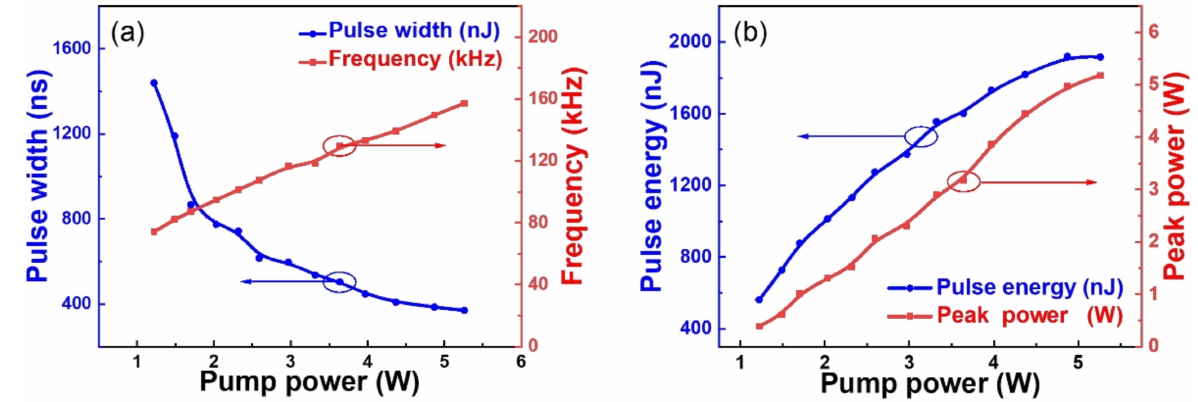
Figure 5. ( a ) Repetition frequency and pulse width as functions of the pump power. ( b ) Peak power and pulse energy as functions of the pump